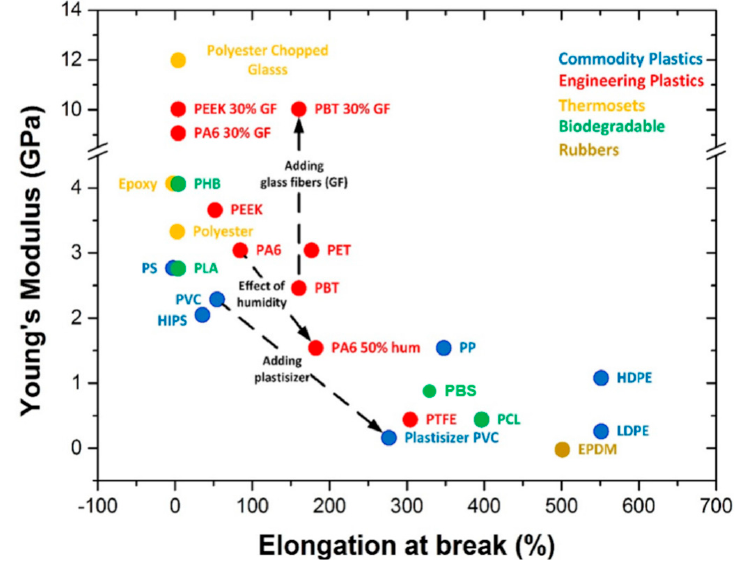
Figure 3. A comparison of the intrinsic properties (mechanical characteristics) of usually utilized plastic materials, engineered polymers, rubbers, bio-based polymers, thermosets, and plastic materials [127]. Table 2. Bioplastics as food contact materials